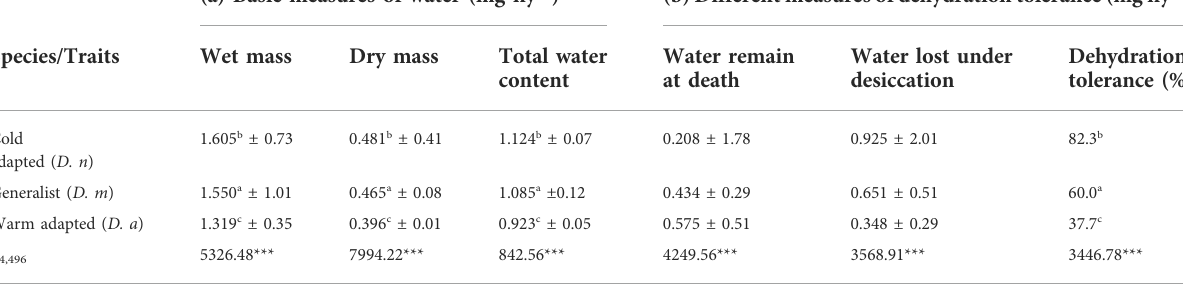
TABLE 3 Data (mean ± SE) on basic measures of water balance related traits (a) and dehydration tolerance (b) in Cold adapted ( D. n) , generalist ( D. m) and warm adapted ( D.a) species. (a) Basic measures of water (mg fl y − 1 ) (b) Different measures of dehydration tolerance (mg fl y − 1 ) Species/Traits Dry mass Water remain Cold adapted ( D. n ) Generalist ( D. m